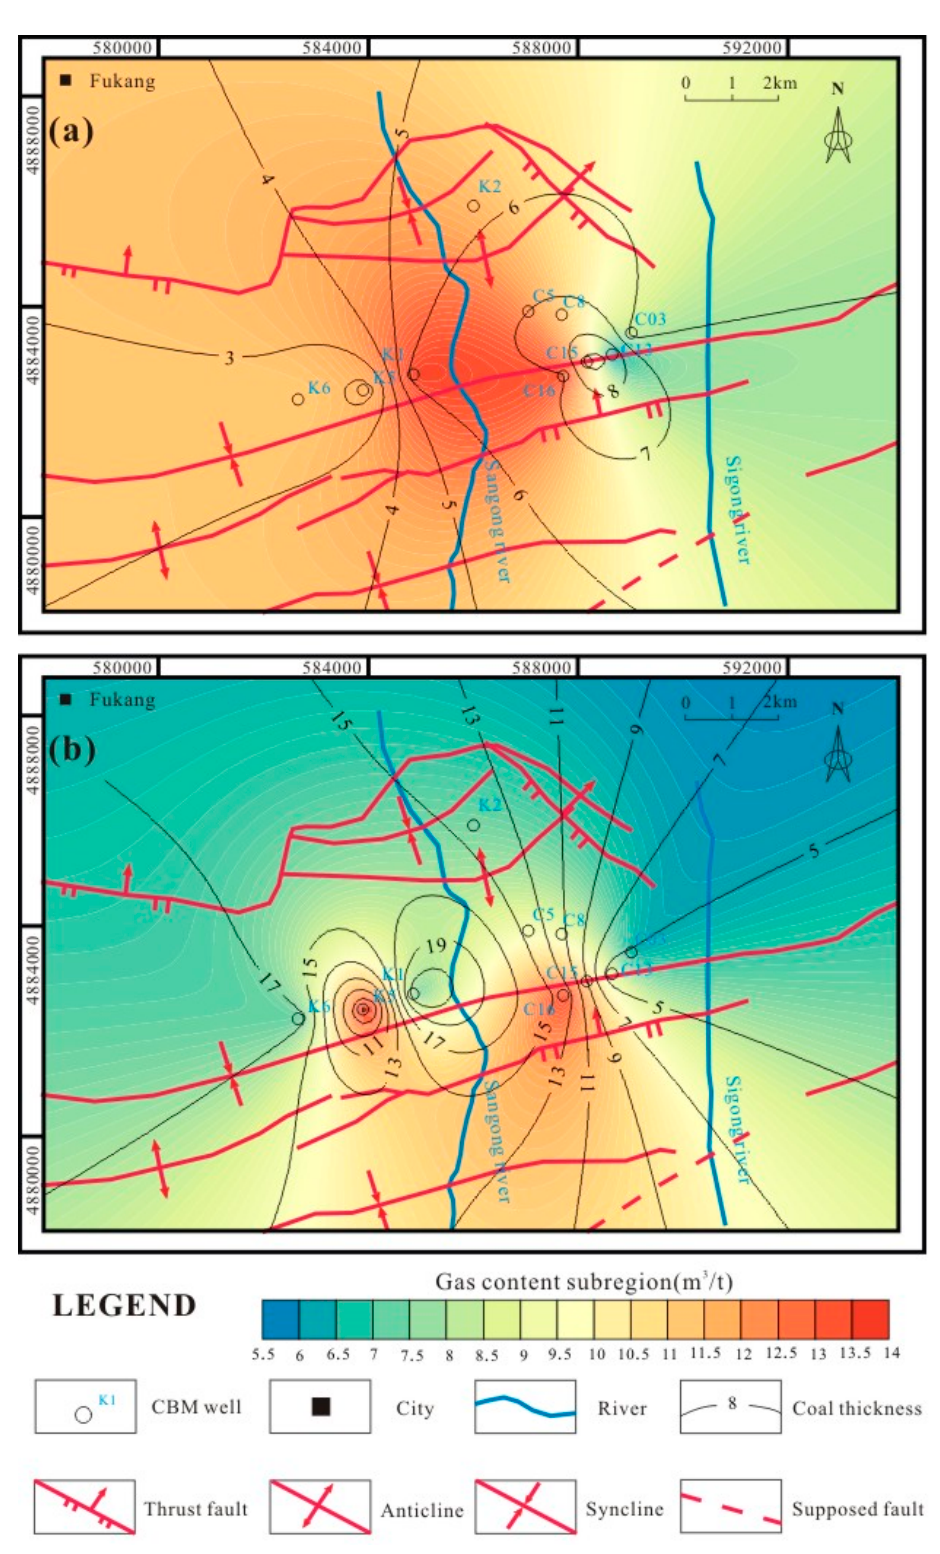
Figure 11. Relationship between gas content and coal thickness of Nos. 45-1 ( a ) and 45-2 ( b ) coal seams in the Fukang syncline (units of contour lines: m for coal thickness and m 3 /t for gas content with different color areas).